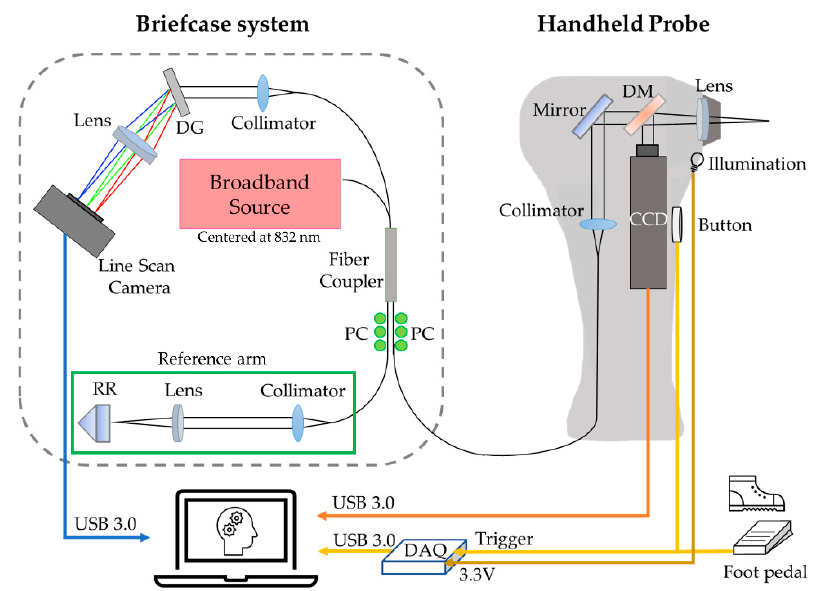
Figure 1. A schematic diagram of the ML-integrated, handheld briefcase OCT system. Data acquisition and processing are performed using a standard laptop. DG: diffraction grating; PC: polarization controller; RR: retroreflector; DAQ: data acquisition system; DM: dichroic mirror to spectrally separate light; CCD: charge-coupled device for simultaneous otoscopy.